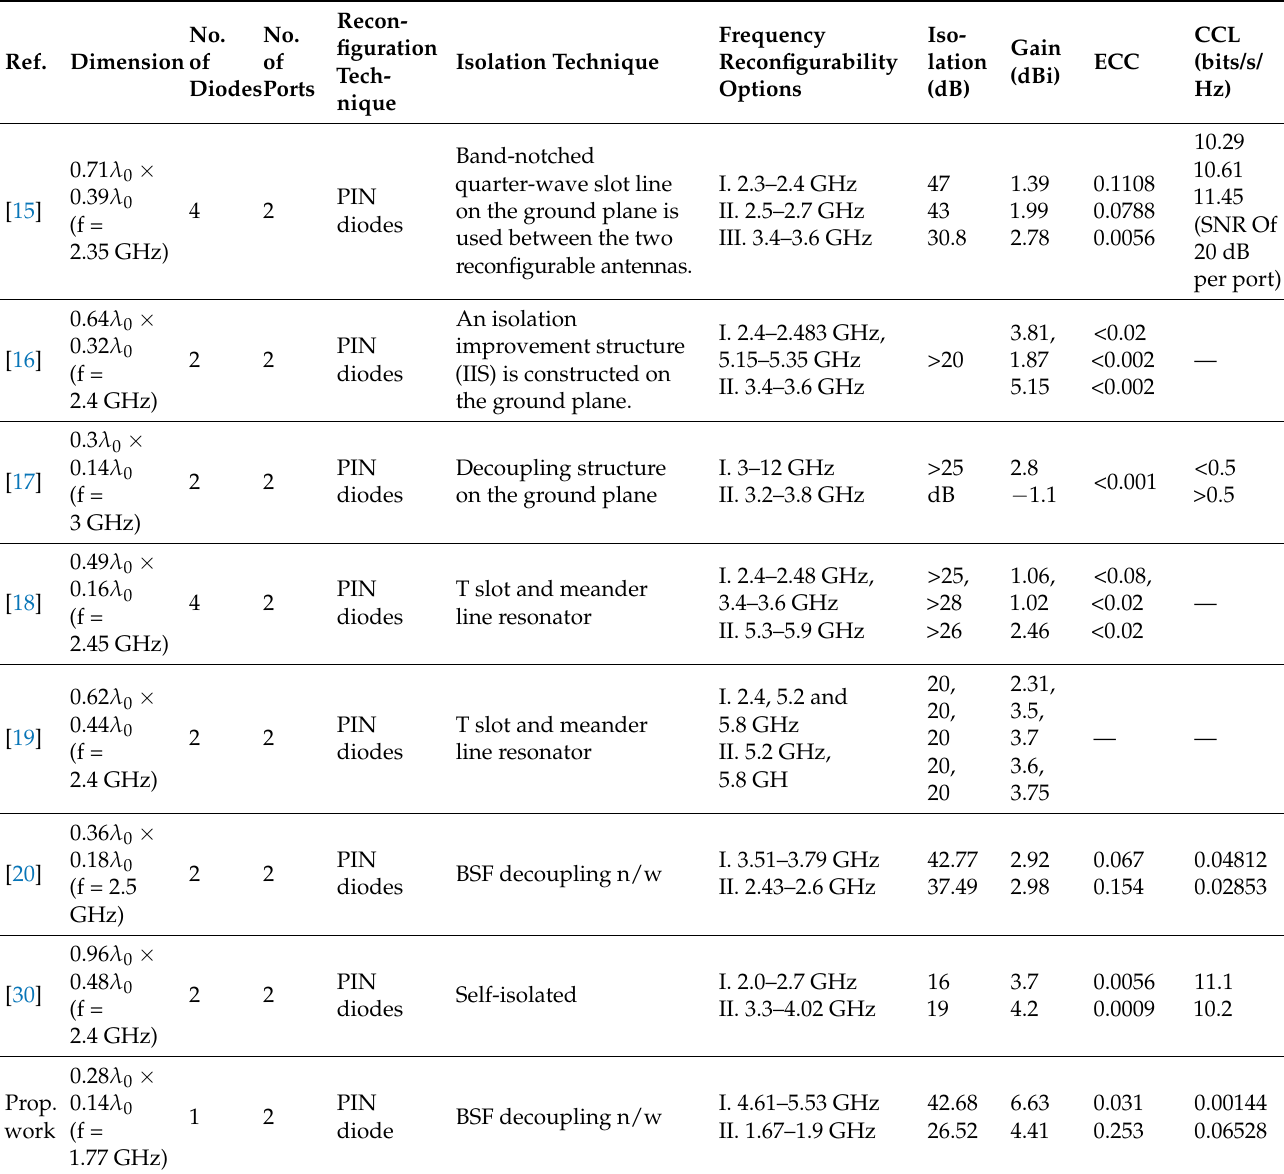
Table 3. Comparison with other decoupling network-based two-port MIMO